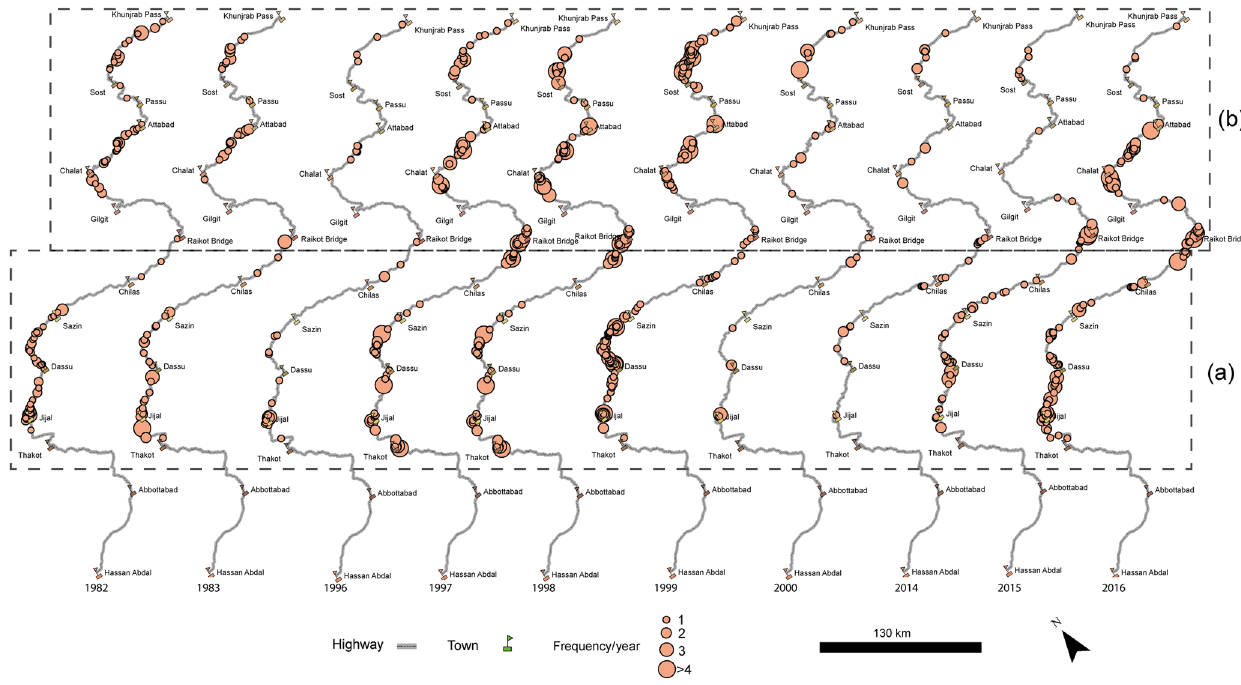
Figure 6. Temporal distribution of landslides along the highway: boxes (a) and (b) represent two problematic sections shown in Fig. 11.